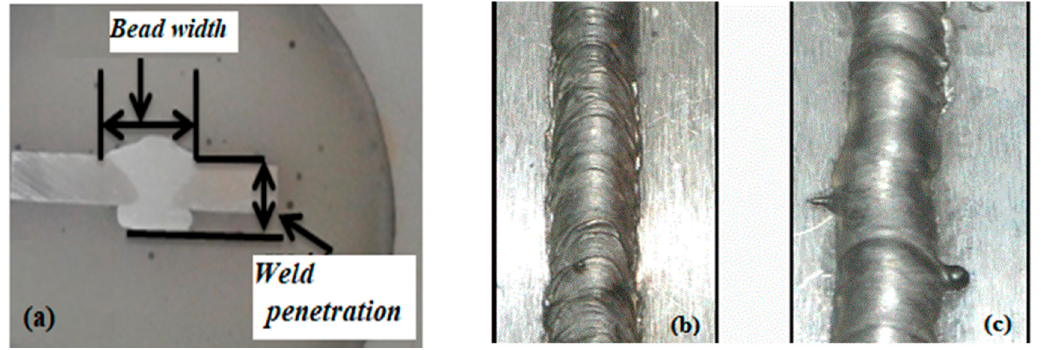
Figure 5. ( a ) Macrostructure of the bead and ( b ) the bead profile without a magnetic field and ( c ) with a magnetic field.